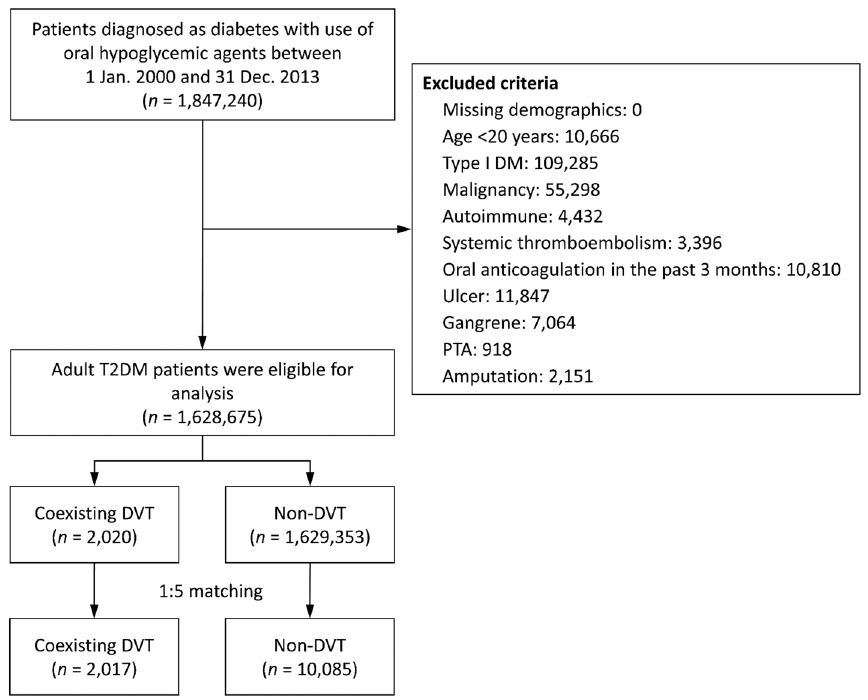
Figure 3. Flowchart of patient inclusion. DM diabetes mellitus, T2DM type II diabetes mellitus, DVT deep vein thrombosis, PTA percutaneous transluminal